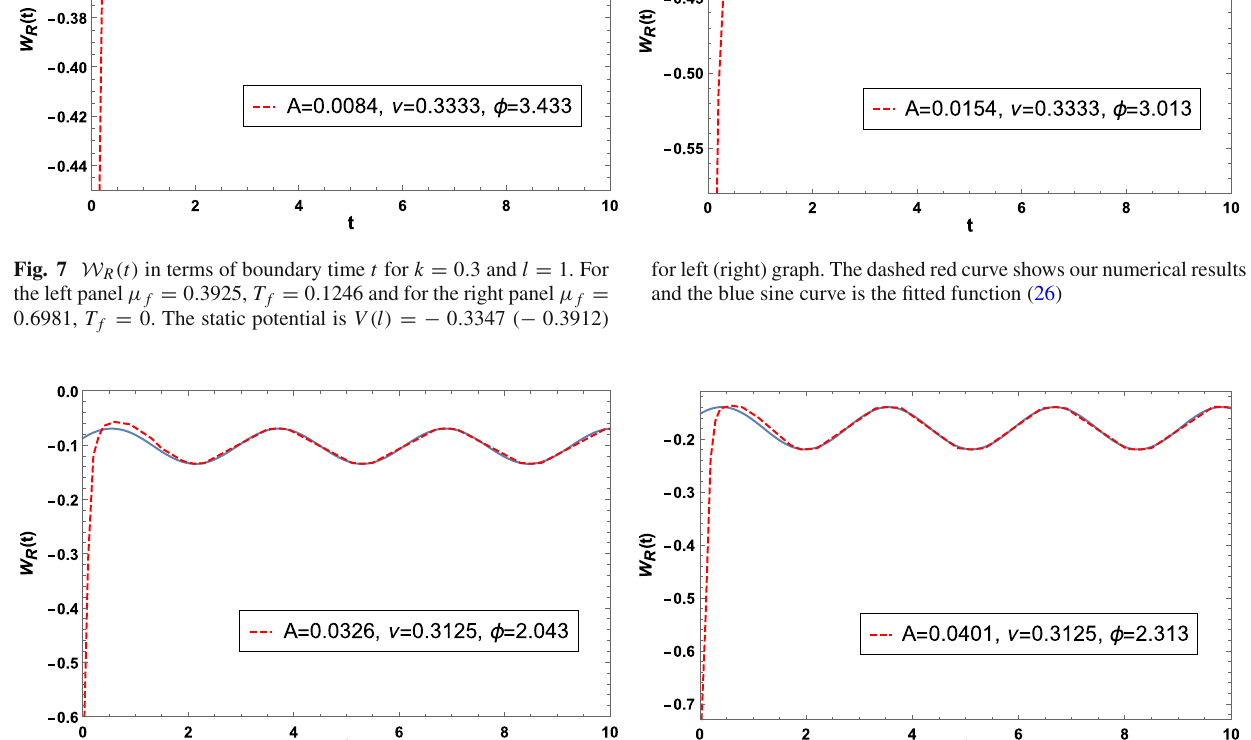
for left (right) graph. The dashed red curve shows our numerical results and the blue sine curve is the fitted function